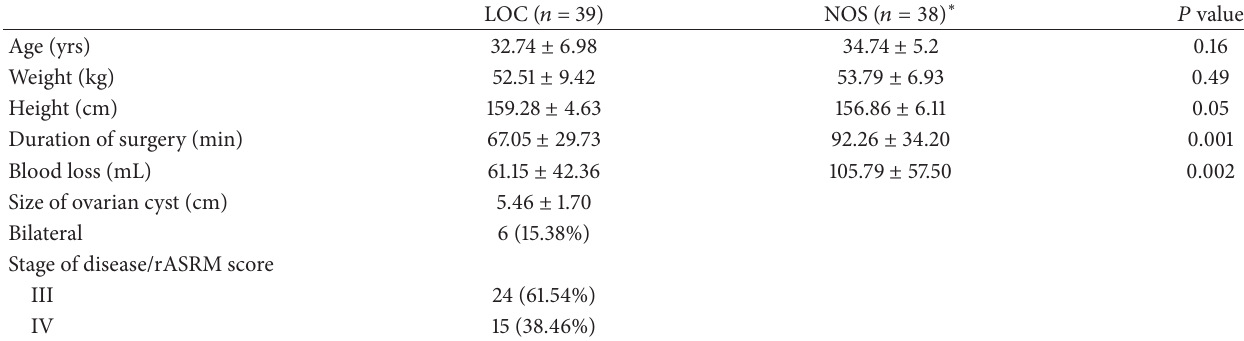
Table 1: Characteristics of the participants between the laparoscopic ovarian cystectomy (LOC) and nonovarian surgery (NOS)